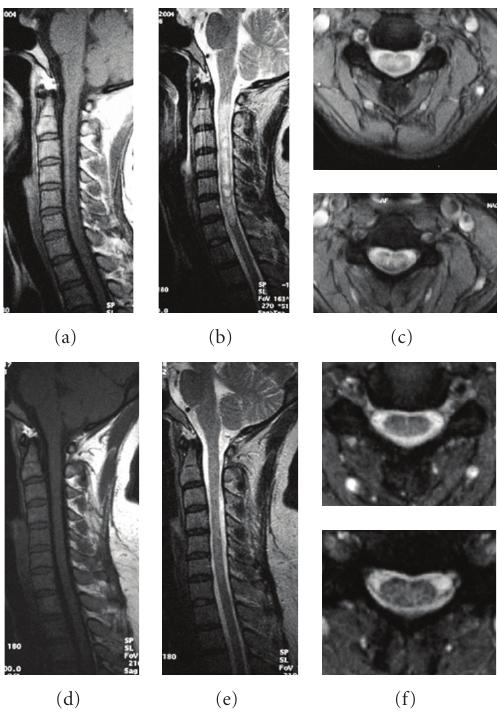
Figure 5: A 40-year-old woman had tetraparesis, C3 sensory level, and urinary incontinence for five months. Pulse methylpred- nisolone and IVIG were initiated with no resolution. However, ATT greatly improved her condition. The MRI changes are as follows: (a) sagittal T1-weighted MRI showing thickening of the cervical cord, (b) sagittal T2-weighted MRI showing a contiguous area of increased signal intensity spanning C2 to C7, (c) axial T2-weighted MRI showing the strong signal derived from the whole cord, (d) sagittal T1-weighted MRI after 2 years of treatment is normal, (e) sagittal T2-weighted MRI after 1 year of treatment, showing a normal spinal cord, and (f) axial T2-weighted MRI, showing no